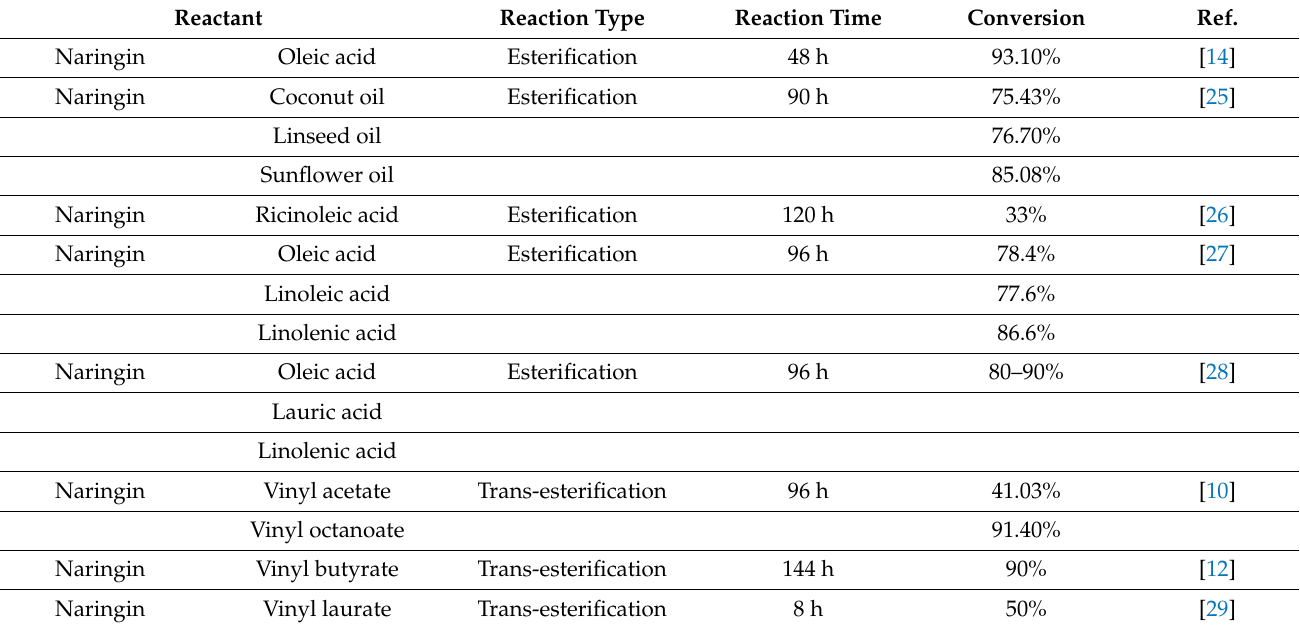
Table 1. Summary of naringin ester conversion by enzymatic